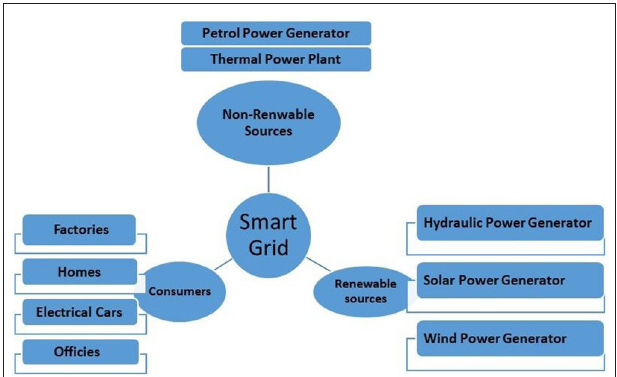
FIGURE 1 | General smart grid